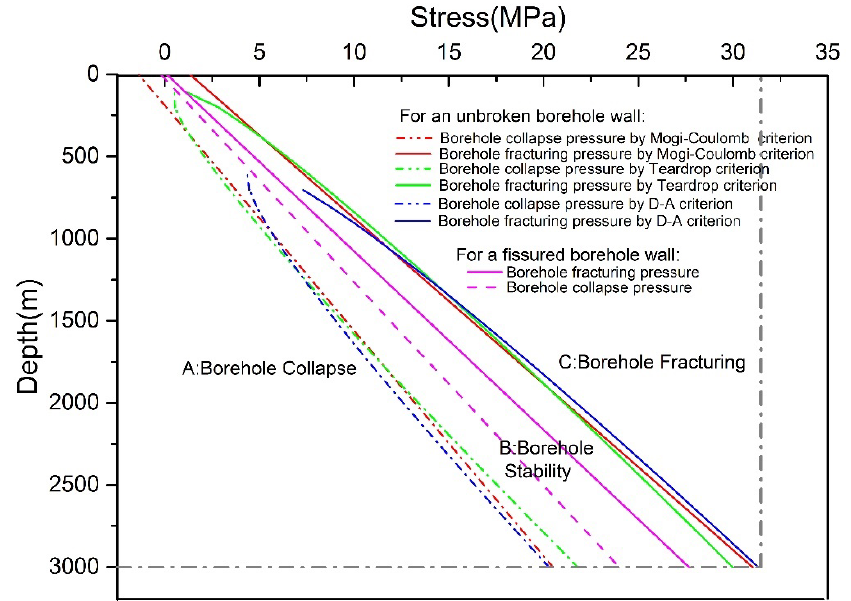
Figure 10. Comparison of the critical borehole pressure changes between an unbroken borehole wall and a fissured borehole wall.